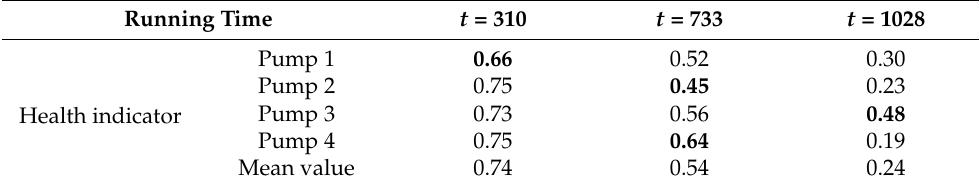
Table 6. Relationship between running time and health indicators.